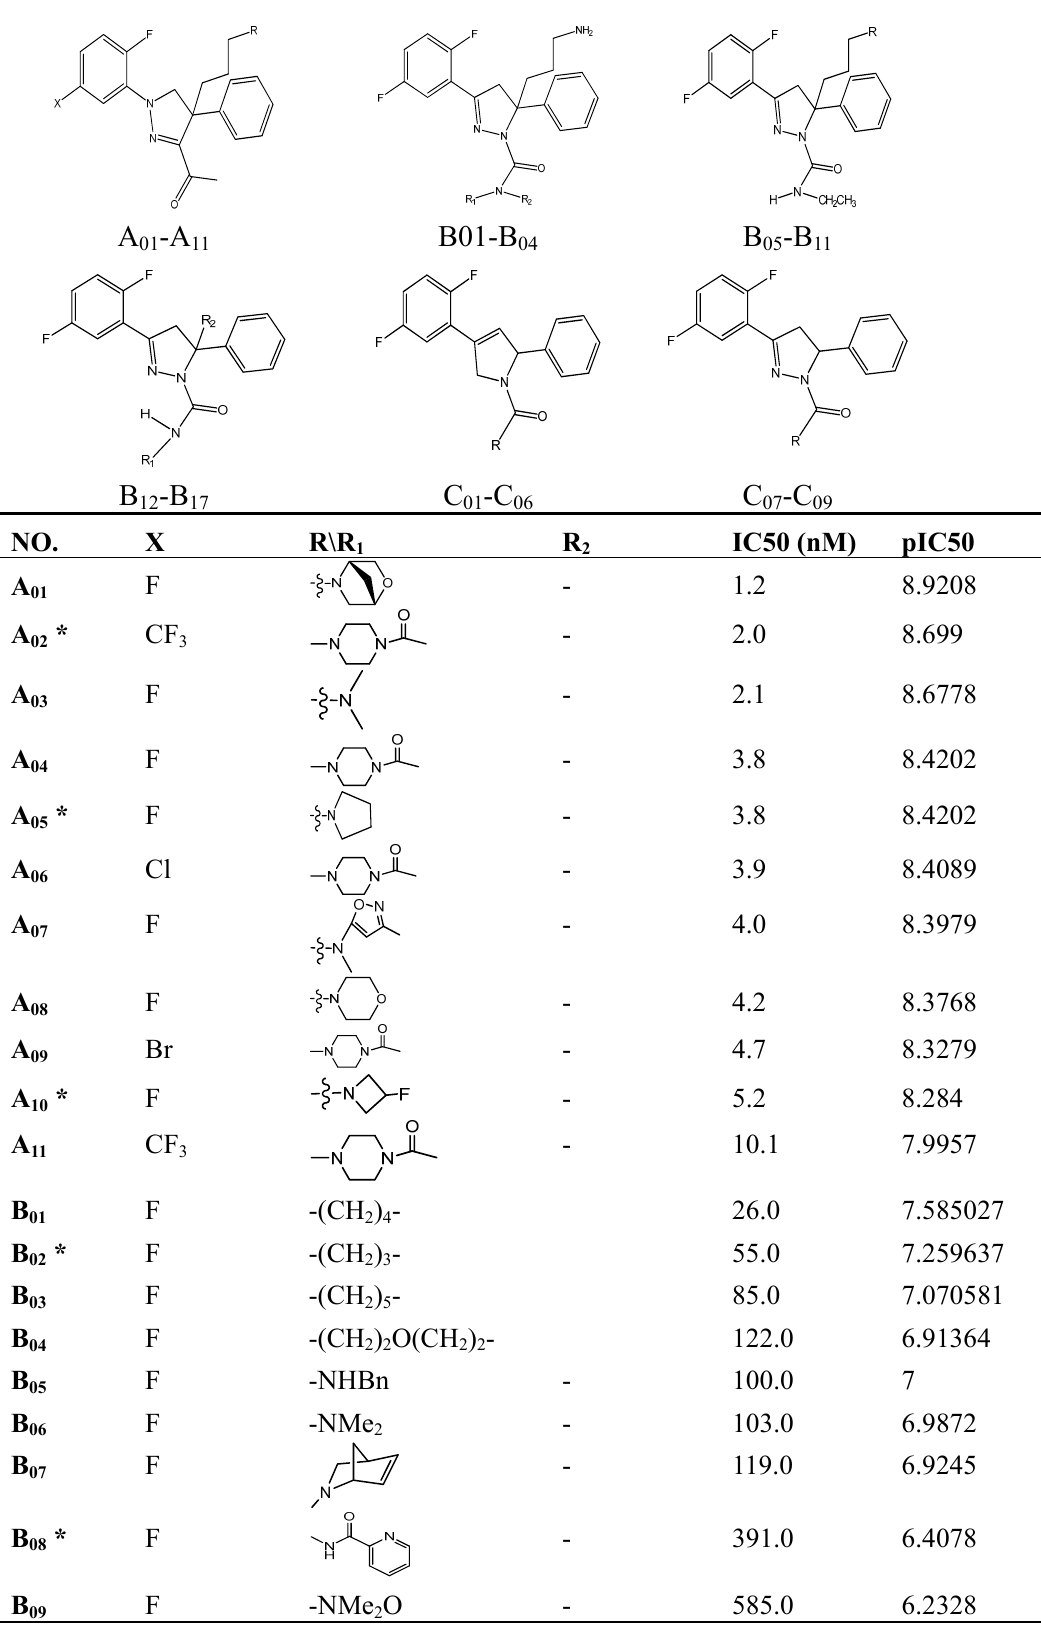
Table 1. The molecular structures and inhibitory activity of Eg5